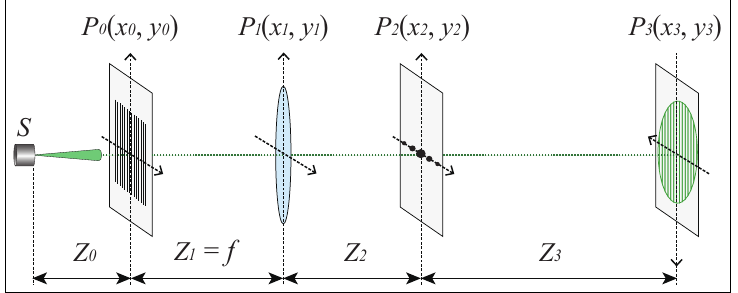
Figure 2. Sketch of the sinusoidal optical signal